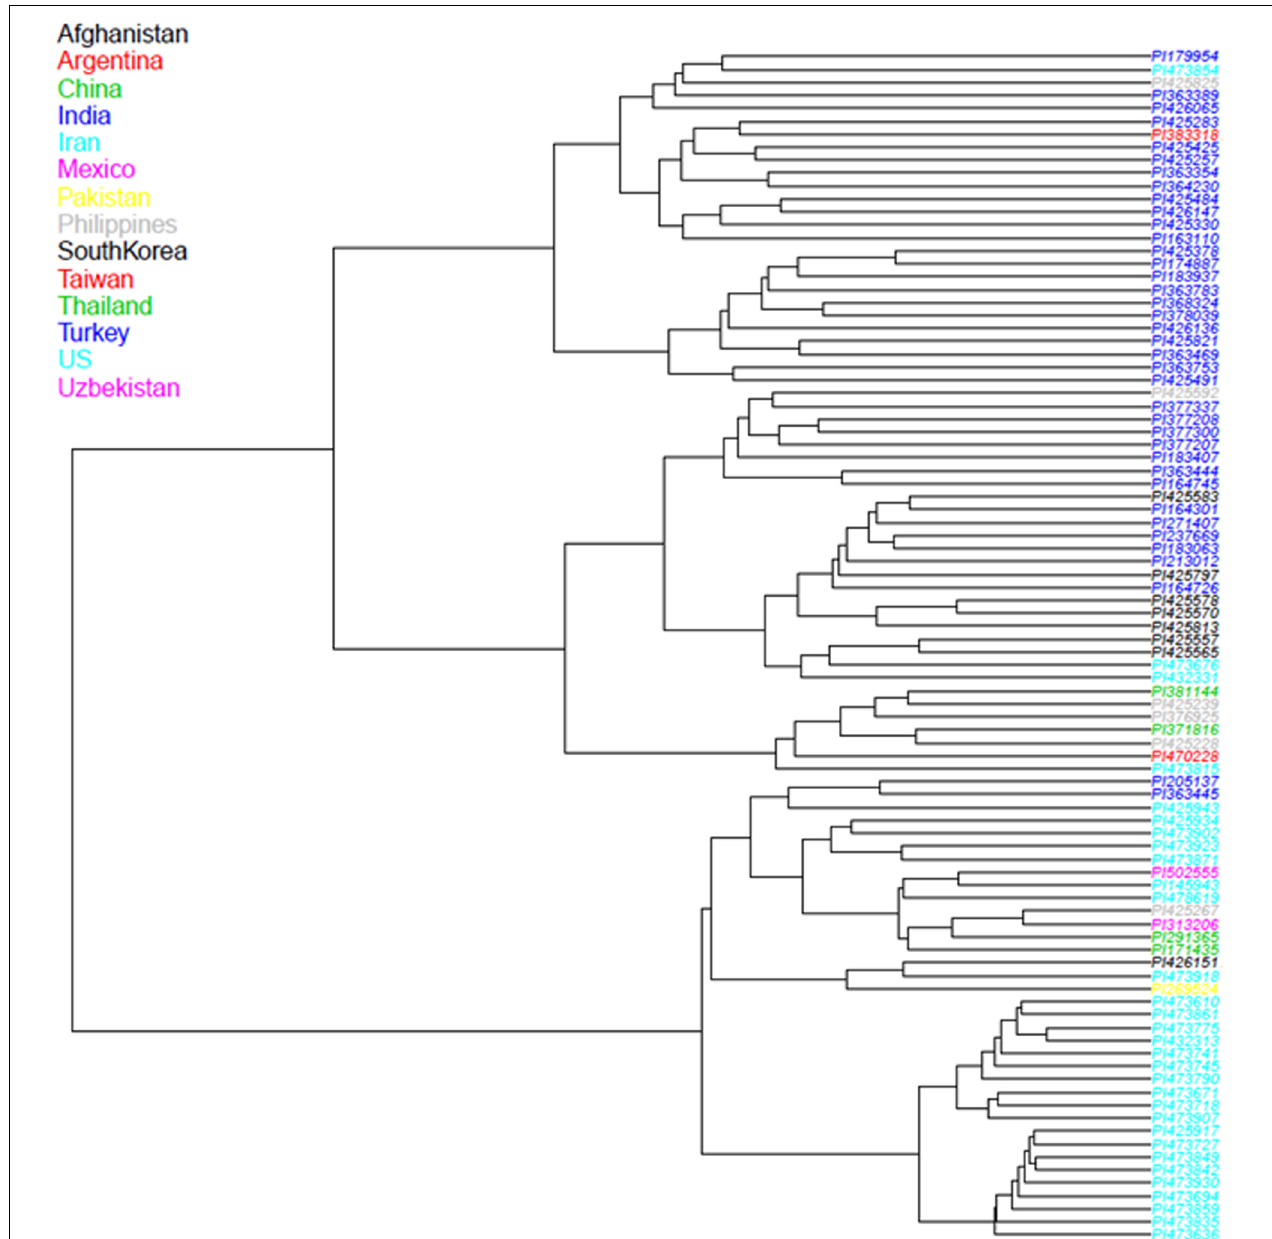
FIGURE 4 | Neighbor-Joining (NJ) dendrogram showing the relationships between 95 mung bean ( Vigna radiata ) accessions from the USDA core collection based on 6,486 SNP markers developed from Genotyping by Sequencing (GBS) with color coding of branches by country and shaded by region in Asia or the Americas. The end of each branch provides the Plant Introduction (PI) number for the